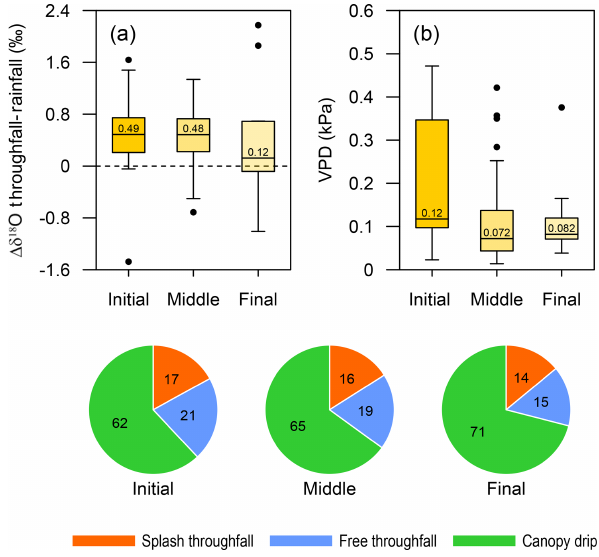
Figure 7. Boxplot of the intra-event dynamic observed in the ini- tial, middle and final stages of 16 rainfall events ( > 10mm) for (a) isotopic shift differences ( δ 18 O TF–RF ) and (b) VPD. Black dots represent outliers. Pie charts shows the proportion of throughfall types (%) for the different stages of rainfall